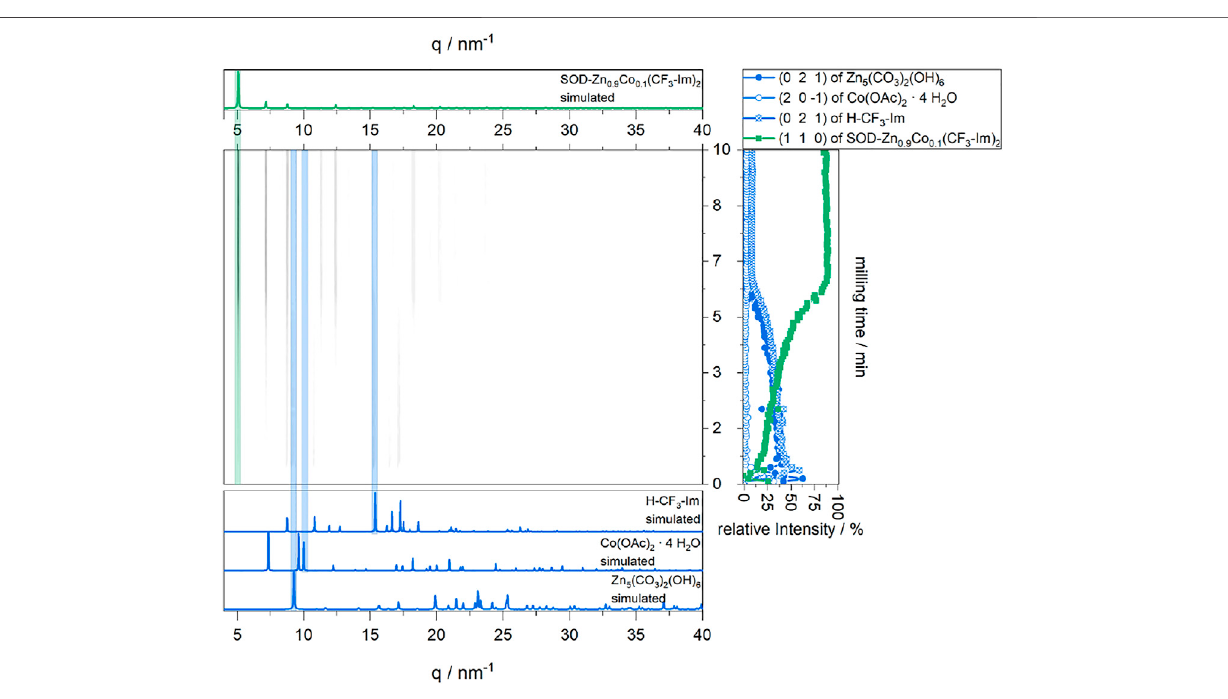
Frontiers in Chemistry |